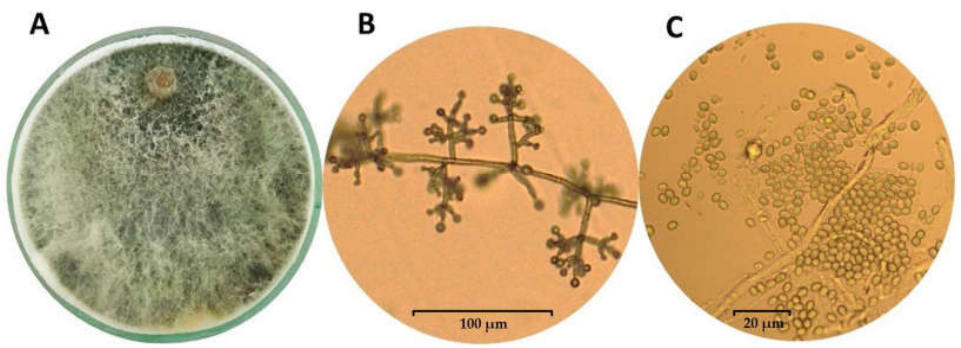
Figure 1. Growth of the mycelium of Trichoderma koningiopsis TkZ3A0 strain ( A ) and the appearance of conidiophores ( B ) and conidia ( C ) observed in microcultures on PDA medium using an Olympus BX53 Upright Microscope equipped with a Olympus XC30 camera.